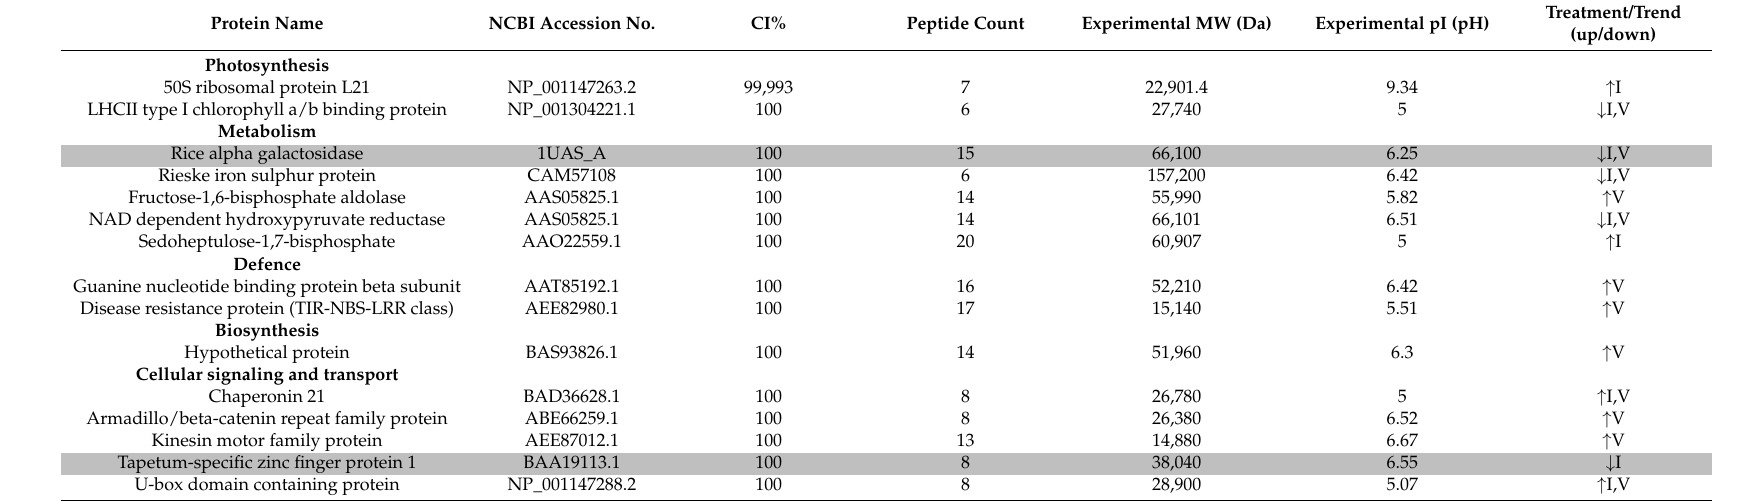
Table 3. MS/MS identification of differentially expressed proteins under non-infected insect and virus-infected insect treatments, only in Colombia I variety (relative abundance). Plants were cultivated in a growth chamber under 12/12 h light/dark cycle at a temperature of 25 ◦ C, and relative humidity of 77%. The plants were irrigated daily with water for approximately 30 days to keep the soil moist. The unstressed and stressed plants were kept in the same growth chamber. CI % = protein score; proteins with 55 or more were considered successfully identified. Treatment: I = non-infected insect, V = virus-infected insect. Trend: increase ↑ /decrease ↓ respect to control group. Proteins used in the serological assay are highlighted in